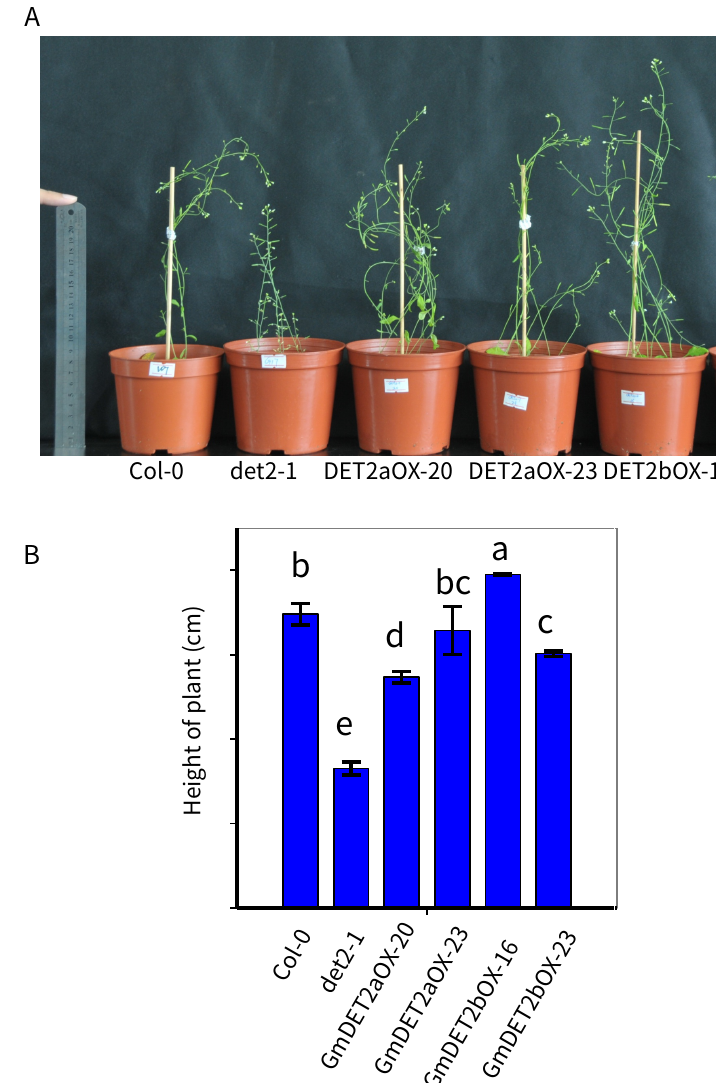
Figure 9. Ectopic expression of GmDET2a and GmDET2b rescued the height of Atdet2-1 . The height of 50-day-old wild-type Col-0, Atdet2-1 and transgenic lines were measured ( A ). Results are the means ± SD from four independent experiments, and one-way ANOVA was used to detect the differences among Col-0, Atdet2-1 and transgenic lines in the det2-1 background ( B ), with different letters indicating significant differences at the 0.05